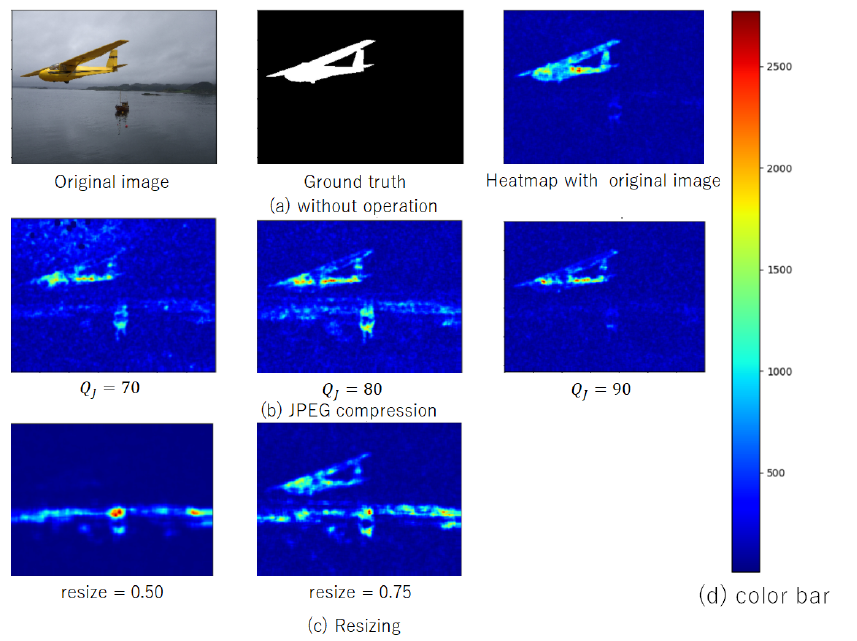
Figure 7. The robustness of the noiseprint algorithm against compression and resizing. ( a ) Without operation; ( b ) JPEG compression; ( c ) Resizing; ( d ) Color